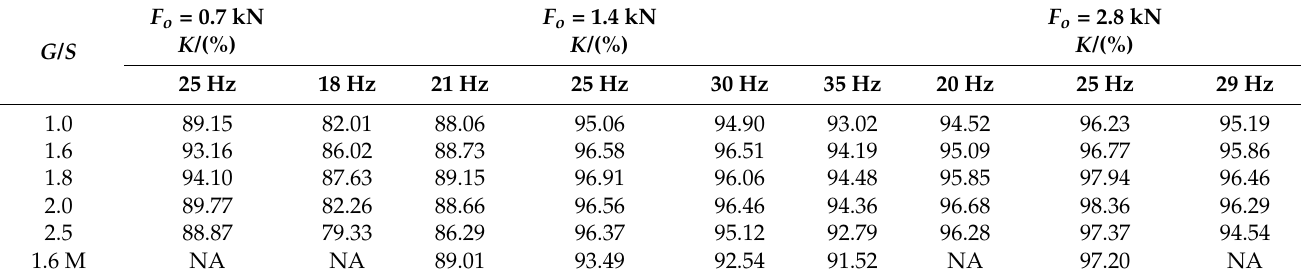
Table 4. The degree of compaction K of UPAB specimens with different G / S